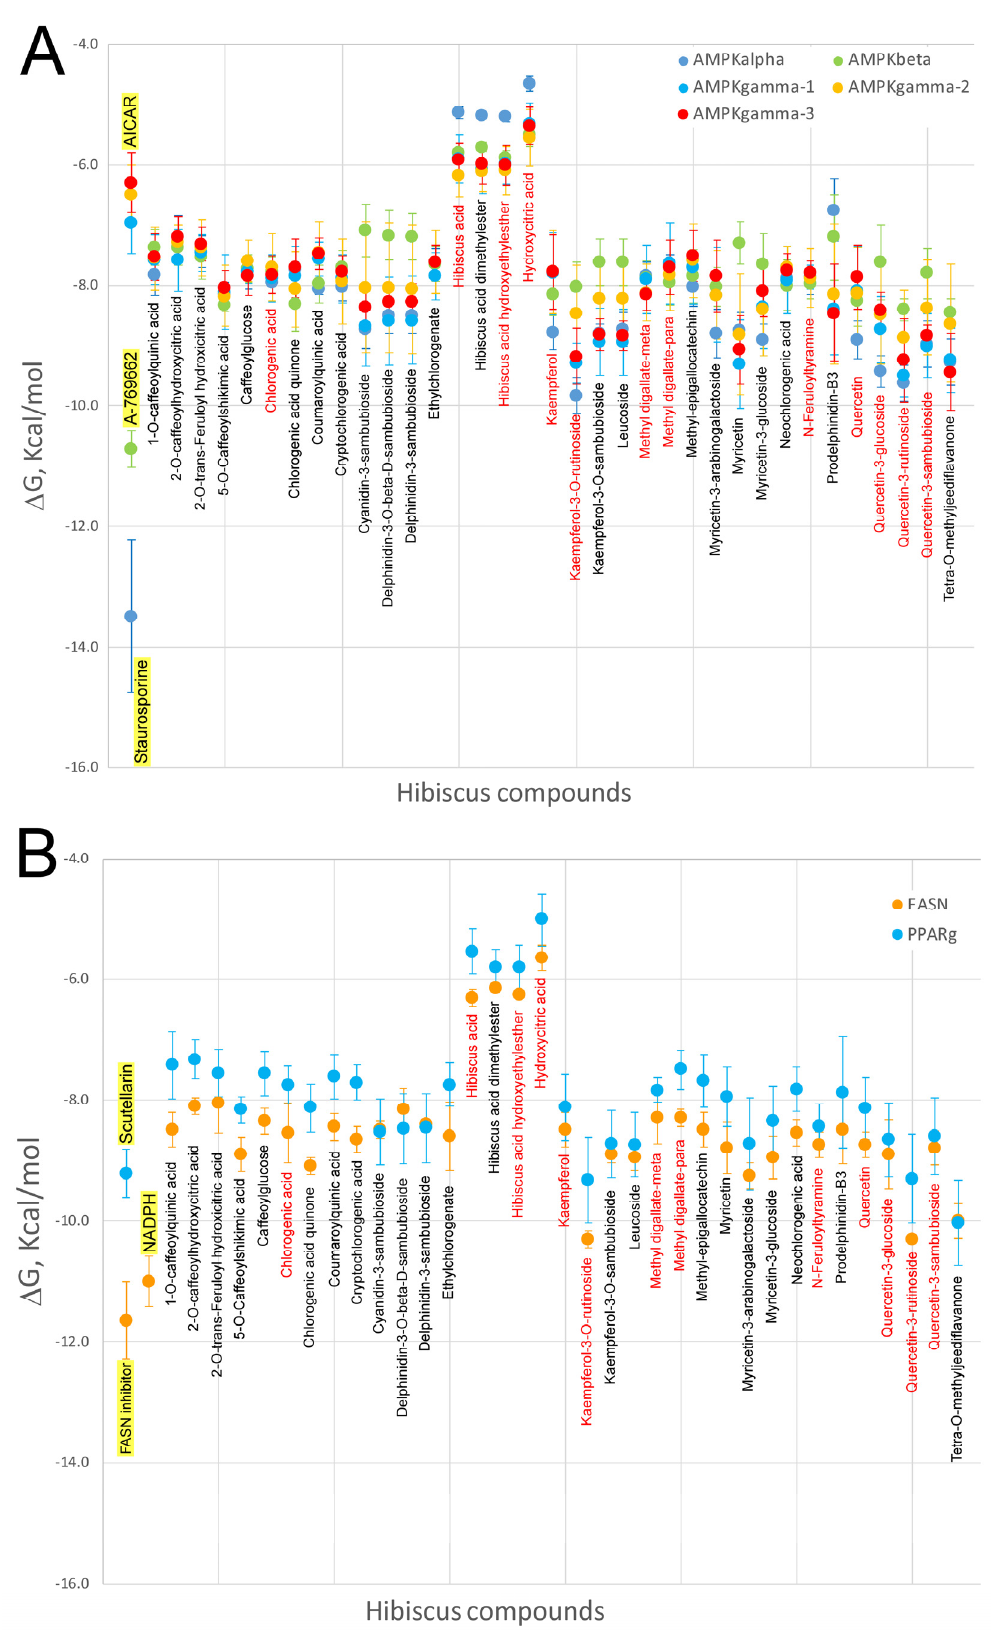
Figure 6. Comparison of the free energy variation ( Δ G, kcal/mol) of the Hibiscus sabdariffa bioactive compounds and X ‐ ray co ‐ crystalized ligands or known modulators (first name of each panel and yellow background) against the main binding sites of: the catalytic binding site of the three AMPK subunits obtained (A); and the catalytic binding site for fatty acid synthase and binding cavity of PPAR ‐ gamma nuclear receptor (B), by molecular docking. The common name of each compound is included under mean and standard deviation plotted in each all four panel. Red color names indicate that these compounds have been identified as plasma metabolites in the bibliography. Virtual screening process was performed as mentioned in Figure 2. 8. Potential Molecular Mechanism of Hibiscus sabdariffa in Obesity: A Global Analysis Obesity ‐ related metabolic disorders are characterized by early cellular events and dysregulation of normal cellular homeostasis. In this sense, obesity must be understood as a multidimensional disease, ranging from adipocyte hypertrophy to the appearance of symptoms related to metabolic alterations. HS derived polyphenols could approach the therapy of this pathology from a global perspective, taking advantage of the pleiotropic character of these compounds. Several altered metabolic biomarkers and proteins have been validated as a prequel in the development of bioenergy alterations. Thus, crucial proteins such as PPAR, FASN, lipase, adiponectin, leptin, MCP ‐ 1, AMPK, NF ‐ kB and SOD, among others, have been proposed by several authors as specific targets in the treatment of obesity ‐ associated metabolic disorders. In this scenario, HS polyphenols seem to interact with all the above ‐ mentioned targets. In addition, their antioxidant capacity may explain many of the benefits granted to this plant. Among the putative processes involved in the molecular effects of HS polyphenols on obesity are: modulation of the signaling and energy metabolism pathways, regulation of redox homeostasis and inflammation, restoration of mitochondrial functionality and epigenetic machinery regulation. The last process may probably play a key role on the other aspects. The extensive literature on the multiple beneficial effects that HS extract exert on obesity ‐ related diseases, as well as its putative mechanism of action, provides sufficient evidence to conclude